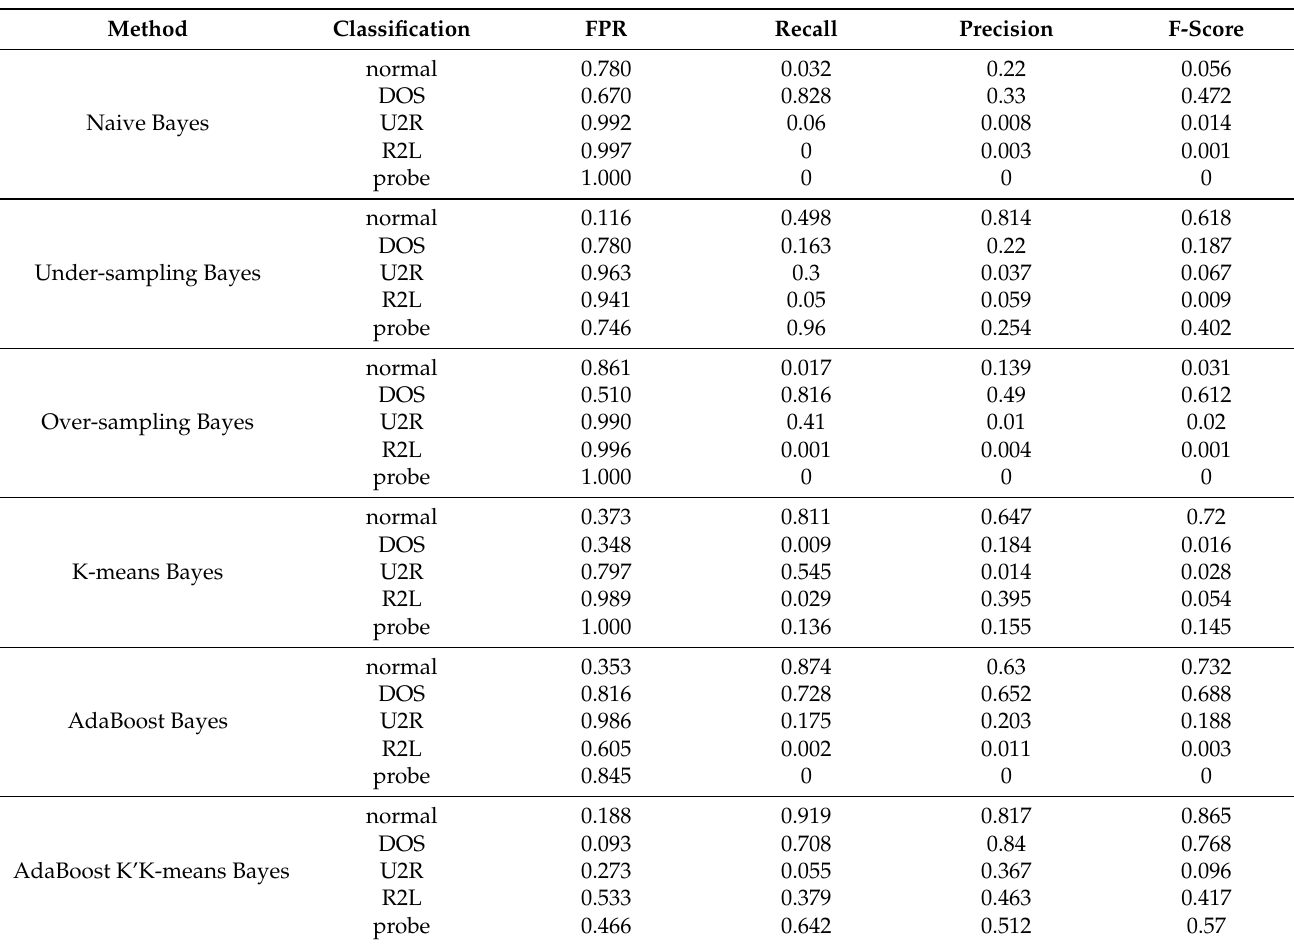
Table 4. The results of different